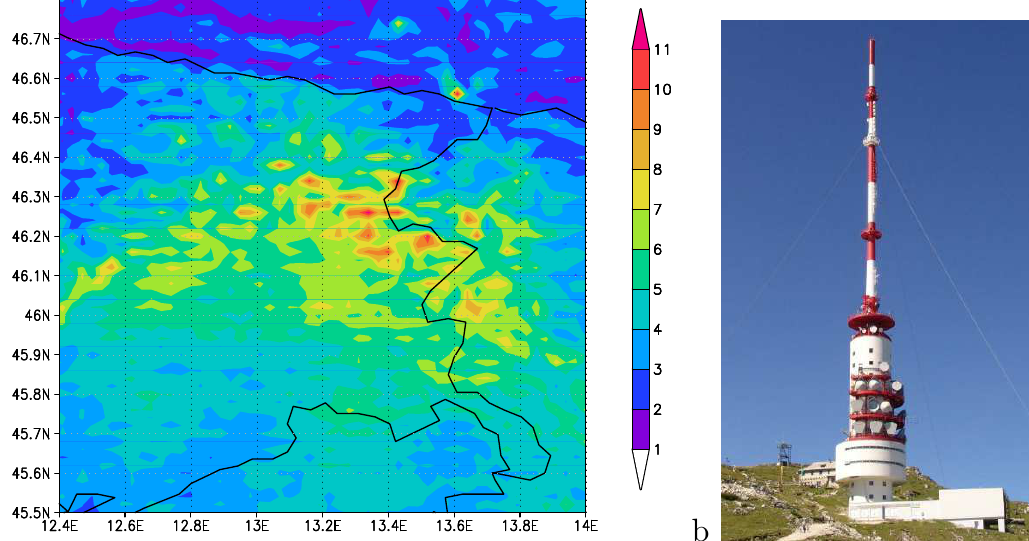
Figure 4. a) Zoom on Friuli Venezia Giulia region of C2G lightning distribution of Fig. 3 which shows the detection of an increased number of C2G strokes at the coordinates 46.6 degrees of latitude and 13.6 degrees of longitude in the nearby Dobratsch transmitter tower in Austria shown in b), which is a 165 m high tower on the Dobratsch mountain of 2115 m asl near Villach. the scale of Fig. a is multiplied by a factor of 10 4 .